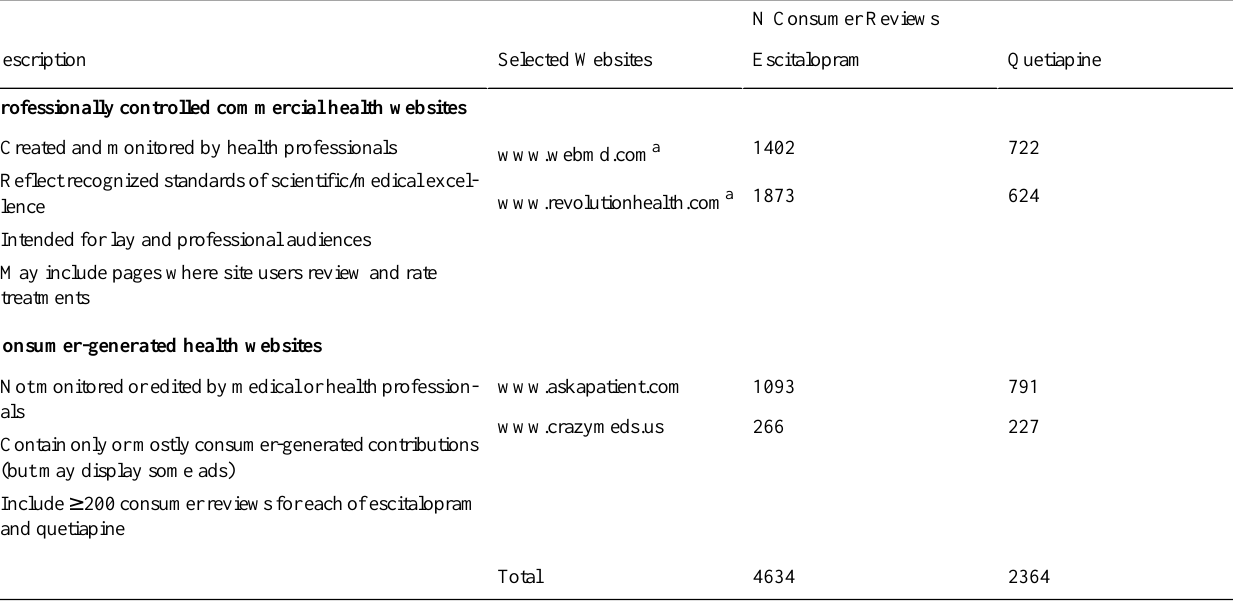
Table 1. Website description and sampling frame for consumer